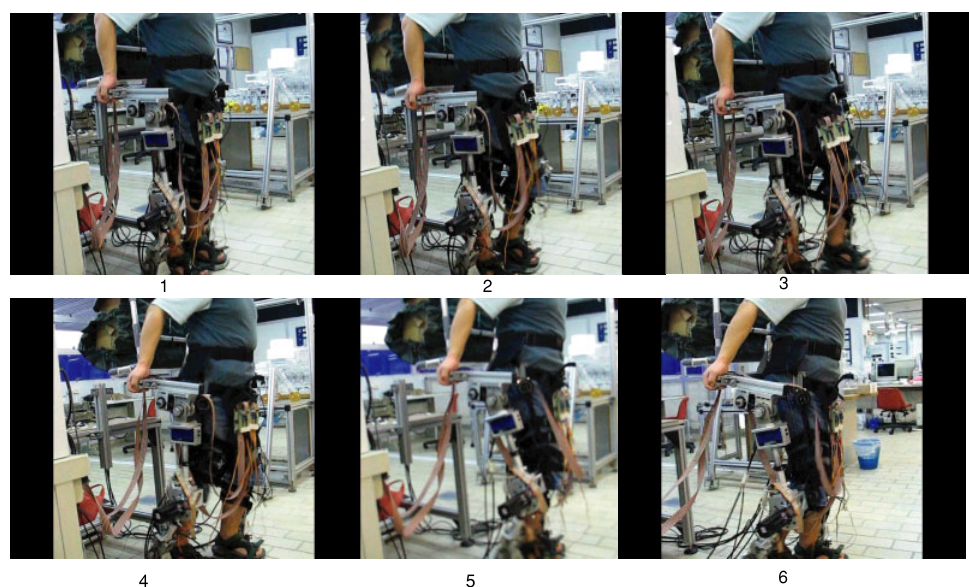
Figure 27 Scheme for walking.